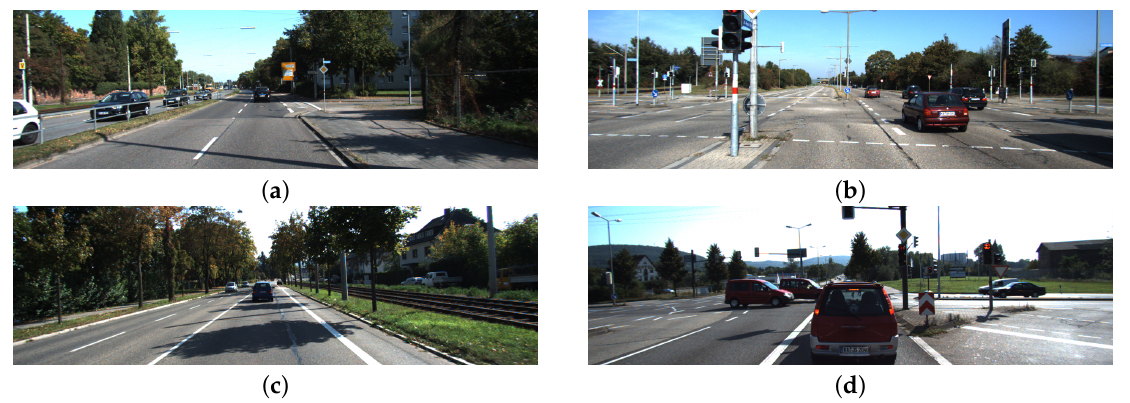
Figure 8. The optical images of KITTI datasets. ( a – d ) represent the scenarios in 0014, 0018, 0056 and 0057 datasets,